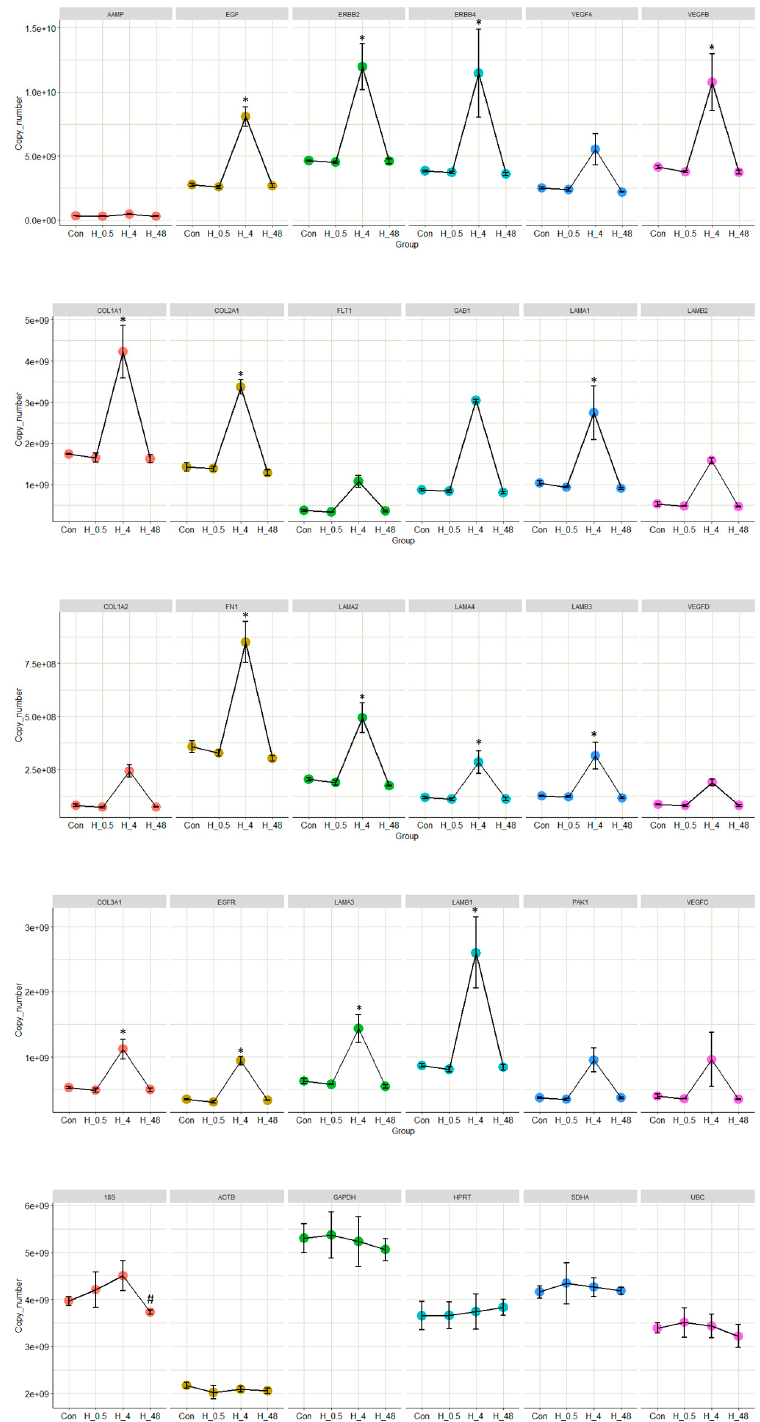
Figure 4. Receptive endometrial analogue RL95-2 cells were treated with trophoblast analogue Jar cell-derived EVs for 30 min, 4 h and 48 h to investigate the effect of trophoblastic EVs on endometrial transcriptome. RNA isolated from RL 95-2 cells was subjected to quantitative real-time PCR for key genes that are known to play critical roles in either extracellular matrix reorganization or signalling by EGFR. Expressions of five housekeeping genes were also measured to ascertain the stability of the RL 95-2 transcriptome during the period of incubation. Results are presented as absolute copy number vs. the group (30 min incubation, 0.5 H; 4 h incubation, H_4; 48 h incubation, H_48; Con, untreated control). *, p < 0.05 vs. untreated control. #, p < 0.05 vs. 4 h